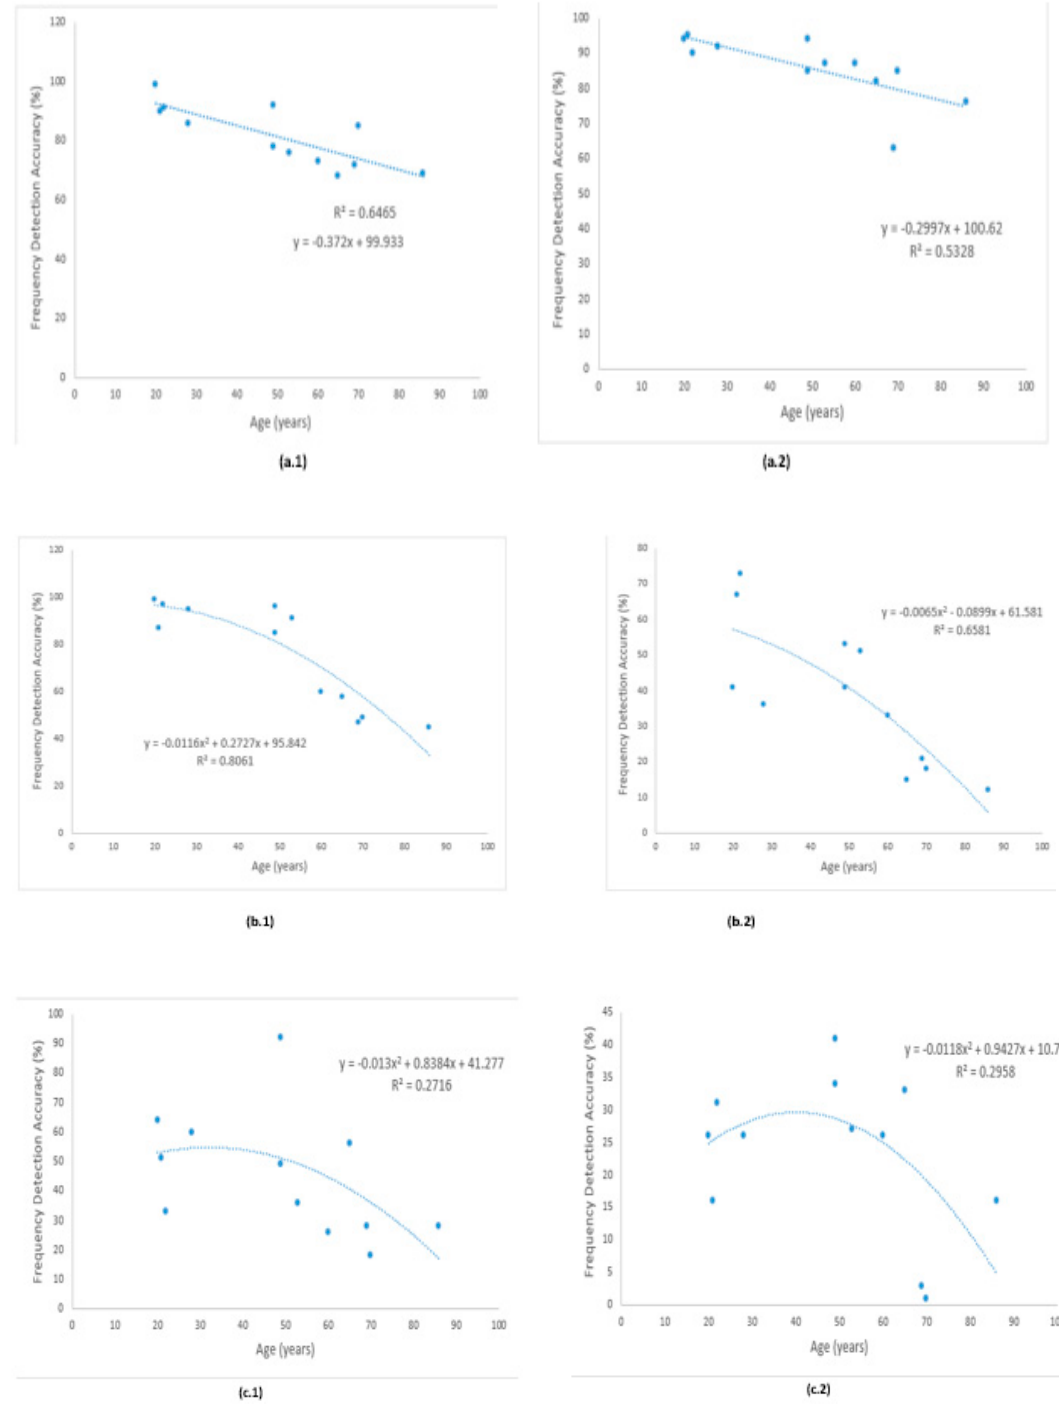
Figure 2. Graphical and mathematical relationship between age and detection accuracy of stimulus frequency bands in SSVEP signals: ( a.1 ) Detection accuracy of theta frequency band in occipital region. ( a.2 ) Detection accuracy of theta frequency band in frontal region. ( b.1 ) Detection accuracy of alpha frequency band in occipital region. ( b.2 ) Detection accuracy of alpha frequency band in frontal region. ( c.1 ) Detection accuracy of beta frequency band in occipital region. ( c.2 ) Detection accuracy of beta frequency band in frontal